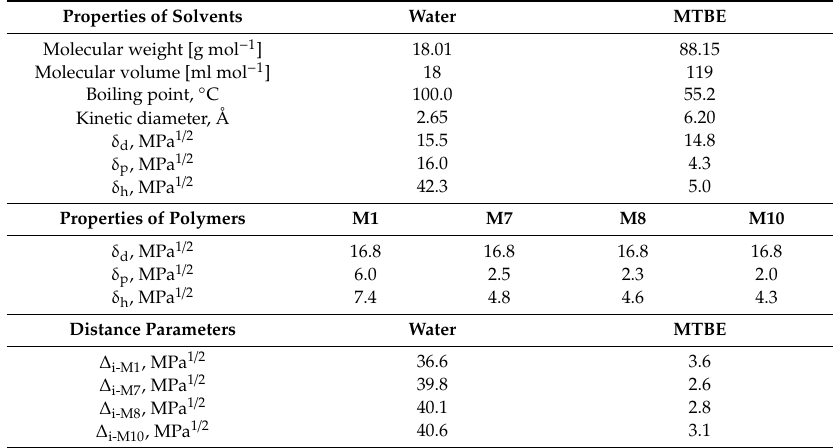
Table 2. The physicochemical properties of water, MTBE and polyalkylmethylsiloxanes with a di ff erent side-chain (M1, M7, M8 and